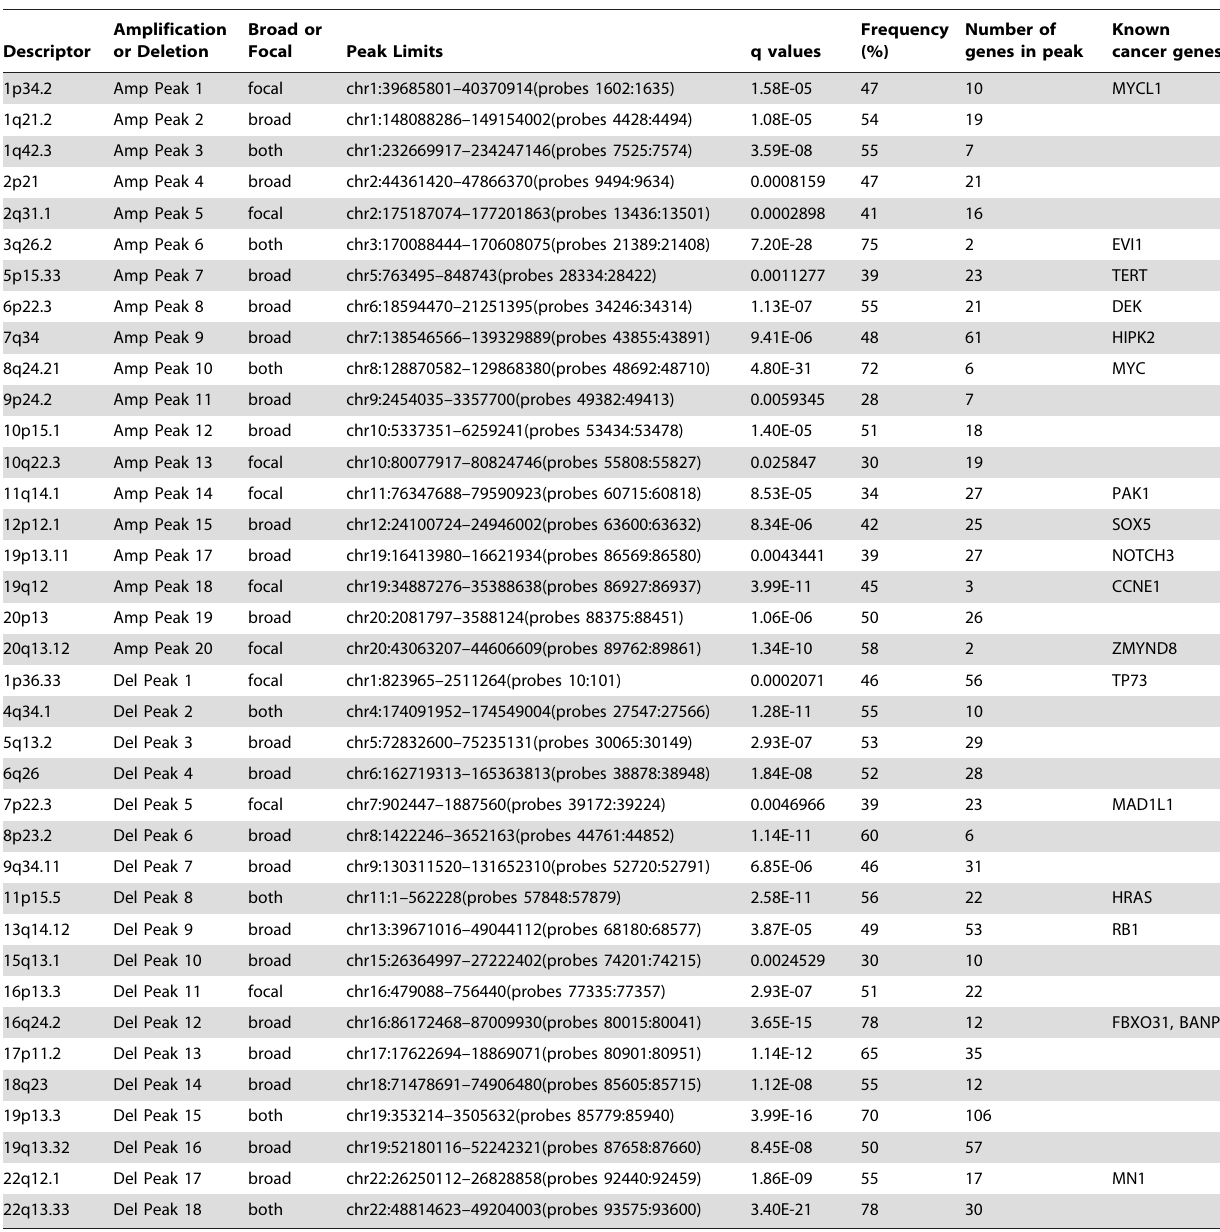
Table 2. Amplifications and deletion peaks identified by